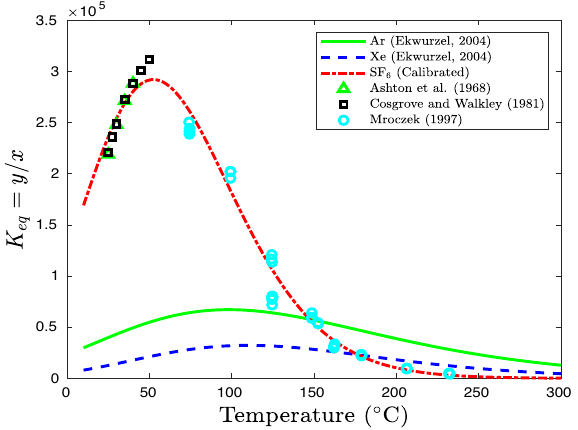
Figure 4. Phase equilibrium coefficient of argon, xenon, and SF 6 as a function of temperature. Experimental data are referred to Ashton et al. 25 , Cosgrove and Walkley 26 and Mroczek 28 .